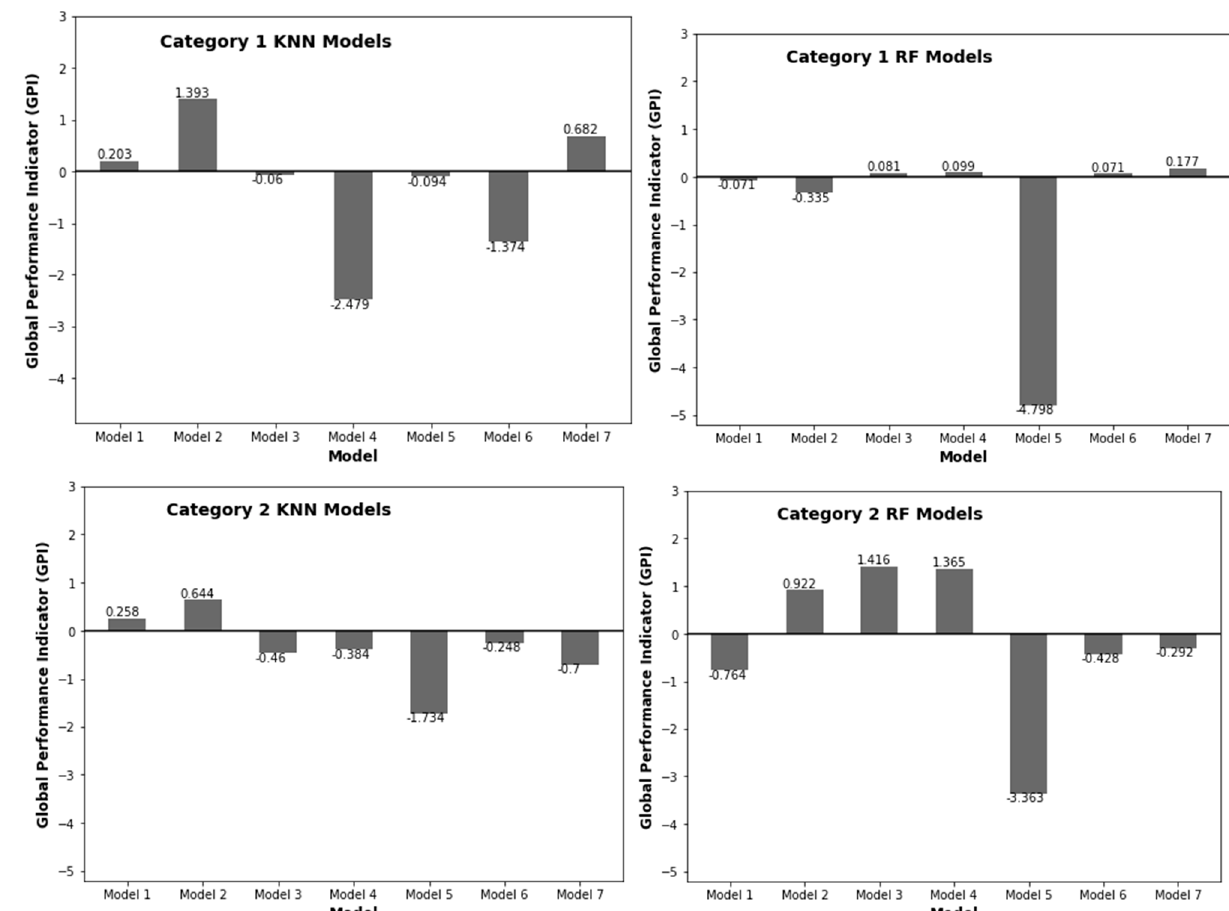
Figure 6. Global performance indicators of both groups of machine learning models for the Indian Climate.